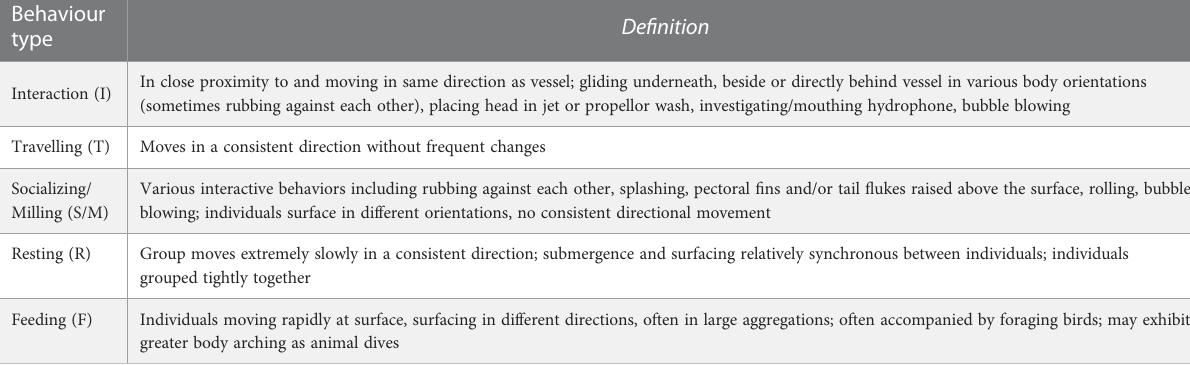
TABLE 2 Classi fi cation of beluga behaviour types (adapted from Malcom and Penner, 2011). Behaviour